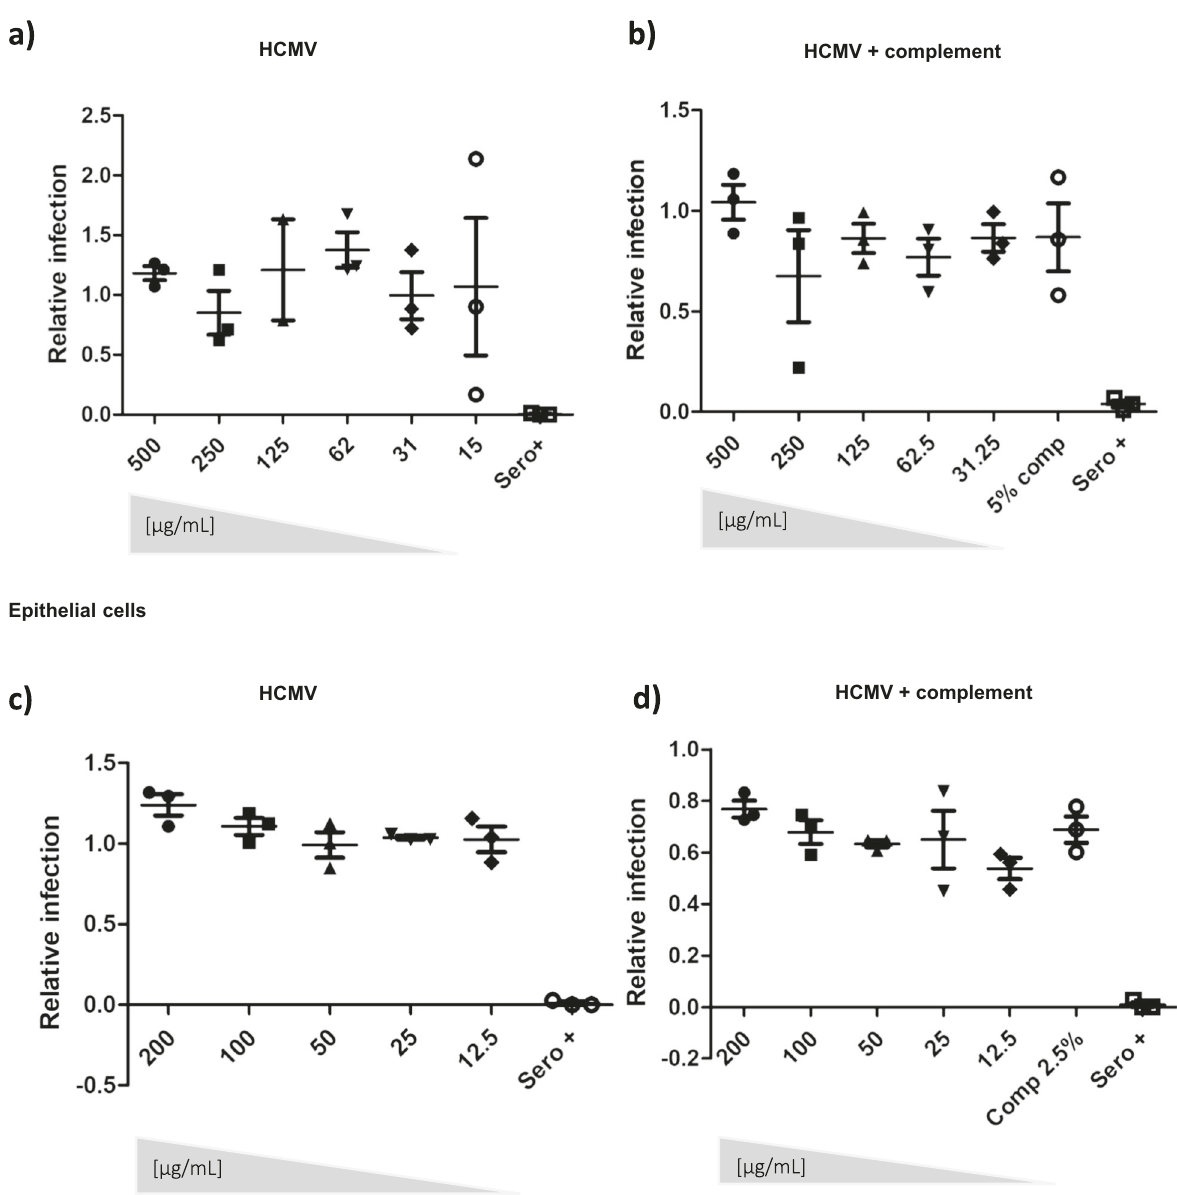
Fig. 5 | An Anti-AD-6 antibody is non-neutralising against cell-free CMV. a , b Serial dilutions of anti-AD-6 pAb were incubated with Merlin ( a ), Merlin in the presence of complement ( b ) for 1hour then used to infect HFFs (MOI=1) and infection scored by IF for IE gene expression. Infection was expressed relative to infection in a no antibody control. c , d Serial dilutions of anti-AD-6 pAb were incubated with TB40/E ( c ), TB40/E in the presence of complement ( d ) for 1hour